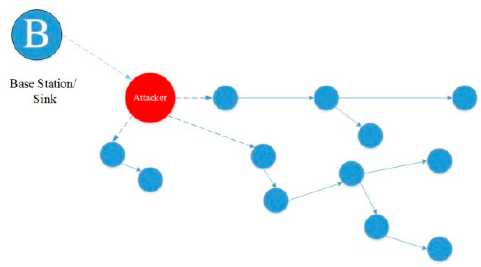
Figure 15. Blackhole attack on WSN [85].